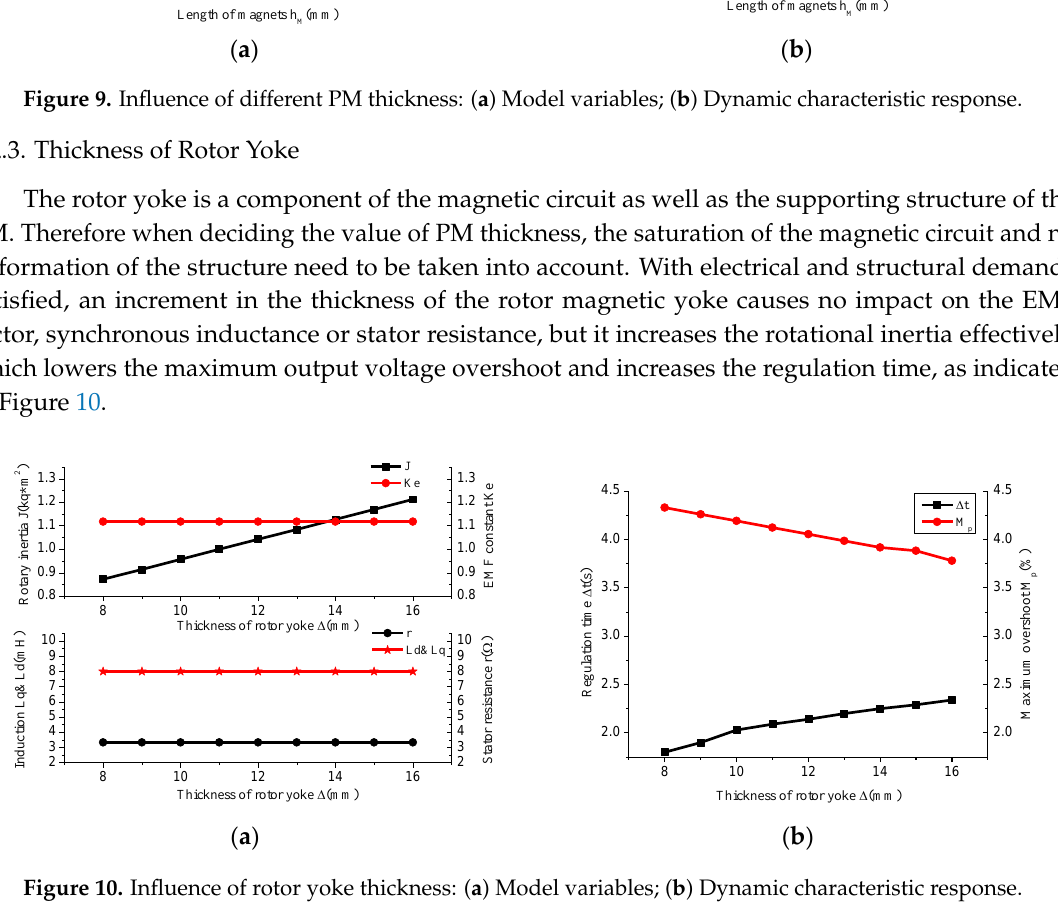
Figure 9. Influence of different PM thickness: ( a ) Model variables; ( b ) Dynamic characteristic response.